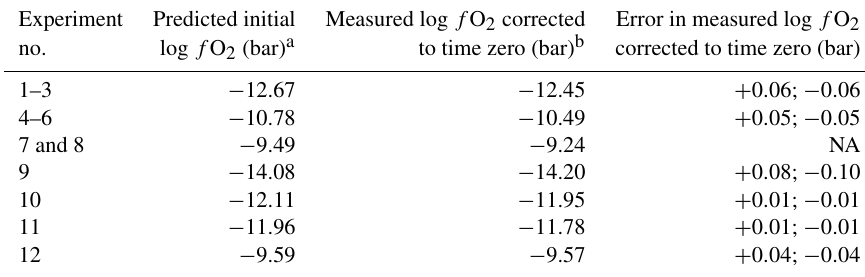
Table 2. Comparison of the predicted and measured initial f O 2 values in the high-pressure experiments. Experiment Predicted initial Measured log f O 2 corrected Error in measured log f O 2